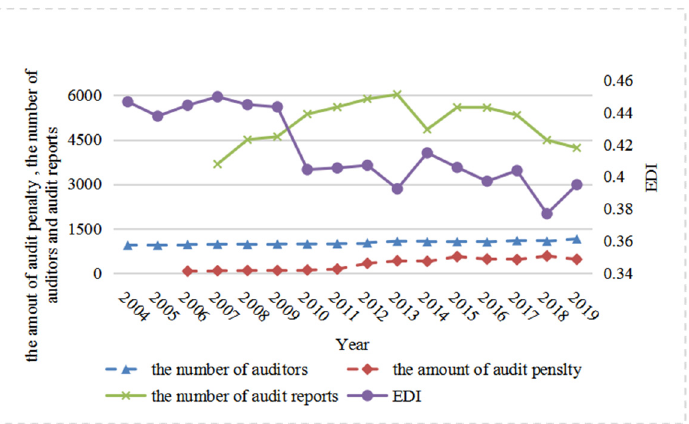
Figure 1. Government environmental auditing and environmental quality trends from 2004–2019.